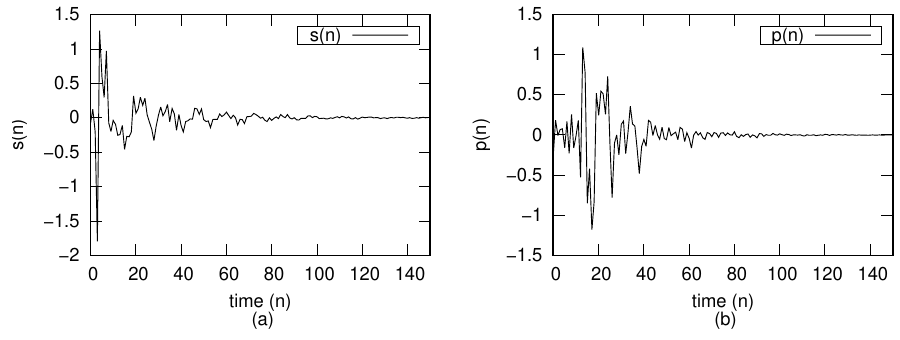
Figure 5. Impulse responses for the secondary ( a ) and primary ( b )